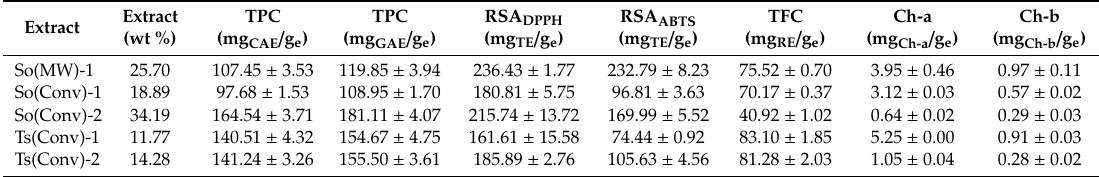
Table 1. Total polyphenols content, radical scavenger activity, total flavonoids, and chlorophyll a and b pigments content for the polyphenolic